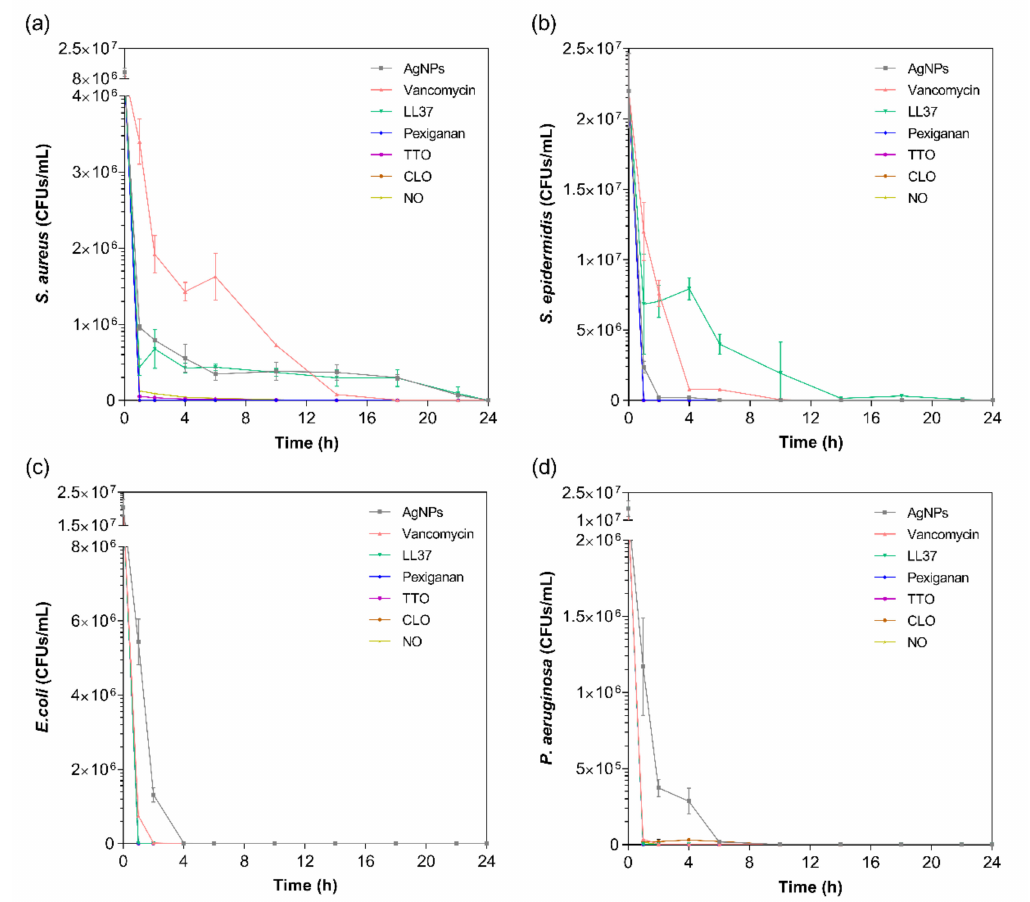
Figure 2. Kill-time curves of AgNPs, vancomycin, LL37, pexiganan, TTO, CLO and NO, at the MICs concentrations, against ( a ) S. aureus , ( b ) S. epidermidis , ( c ) E. coli and ( d ) P. aeruginosa , up to 24 h culture. Data derived from three repetitions. Positive controls for each bacterium (growth without agent) were also conducted, reaching maximum values of ≈ 8.0 × 10 8 colony forming units (CFUs) / mL for S. aureus , ≈ 1.6 × 10 9 CFUs / mL for S. epidermidis , ≈ 1.4 × 10 9 CFUs / mL for E. coli and ≈ 8.7 × 10 8 CFUs / mL for P. aeruginosa after 24 h culture (data not